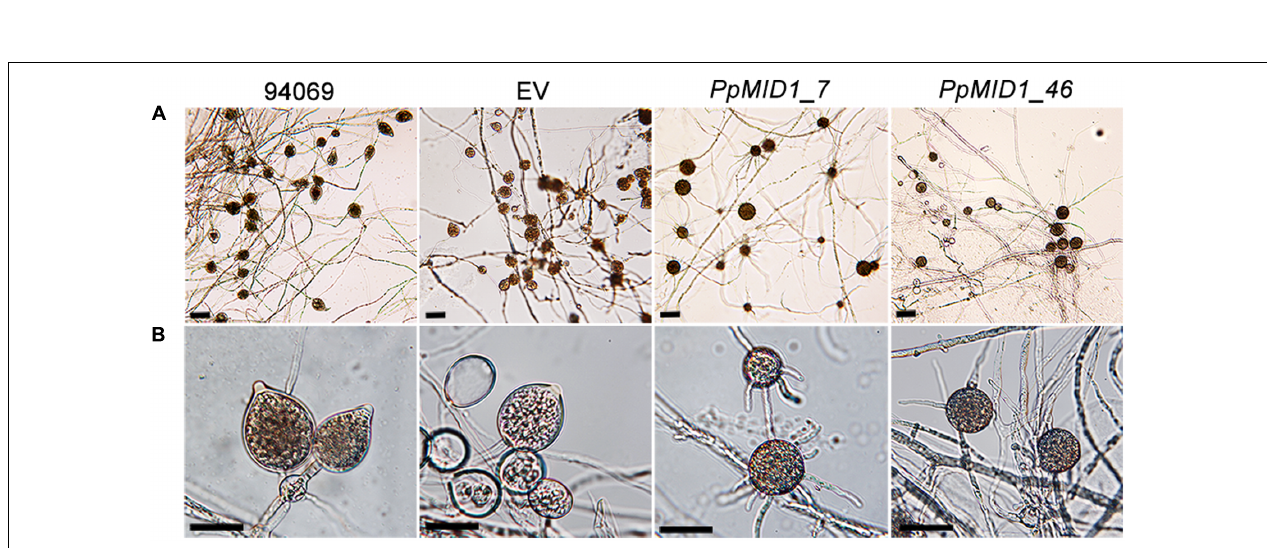
FIGURE 5 | Sporangia produced by PpMID1- silenced transformants show aberrant morphology. Mycelial blocks of PpMID1_7 and PpMID1_46 , EV, and wild-type Phytophthora parasitica (94069) were incubated in 1% V8 juice medium under light at 25 ◦ C to induce sporangium formation. After 3 days, photographs were taken under a microscope. (A) Formation of sporangia; (B) Four-fold magnification of (A) . Bar = 25 µ m.